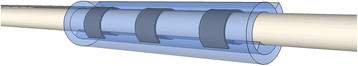
Spiral cuff electrode. Illustration of a self-sizing spiral cuff electrode with continuous or ring contacts.